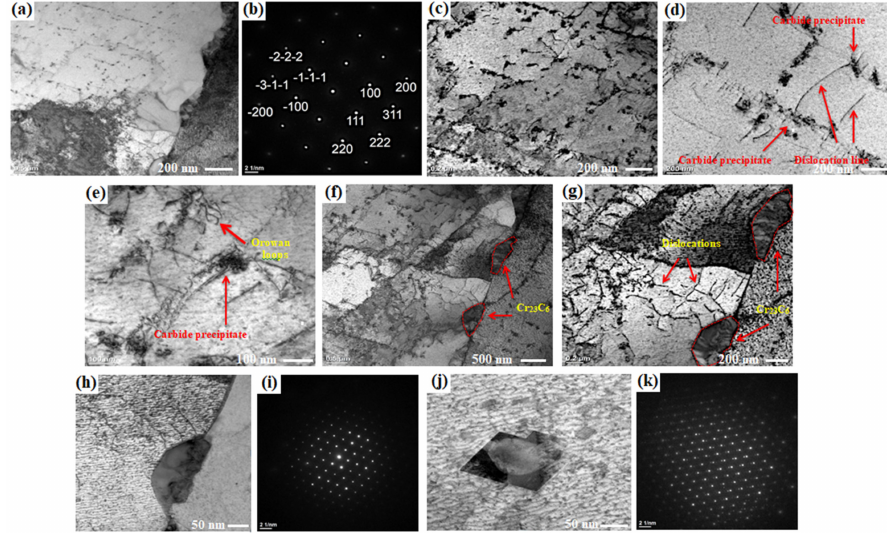
Figure 9. ( a ) TEM image of the selected area diffraction (SAD), ( b ) SAD area, ( c ) dislocations and precipitates distribution, ( d , e ) dislocation at the precipitates, ( f ) carbide precipitate along grain boundary, ( g ) dislocation pile up at the carbide precipitate, ( h ) TEM image of the SAD on grain boundary carbide, ( i ) SAD area on grain boundary carbide, ( j ) TEM image of the SAD on matrix precipitate and ( k ) SAD area on matrix precipitate of the heat-treated sample at 1200 ◦ C after creep test at 800 ◦ C under 100 MPa